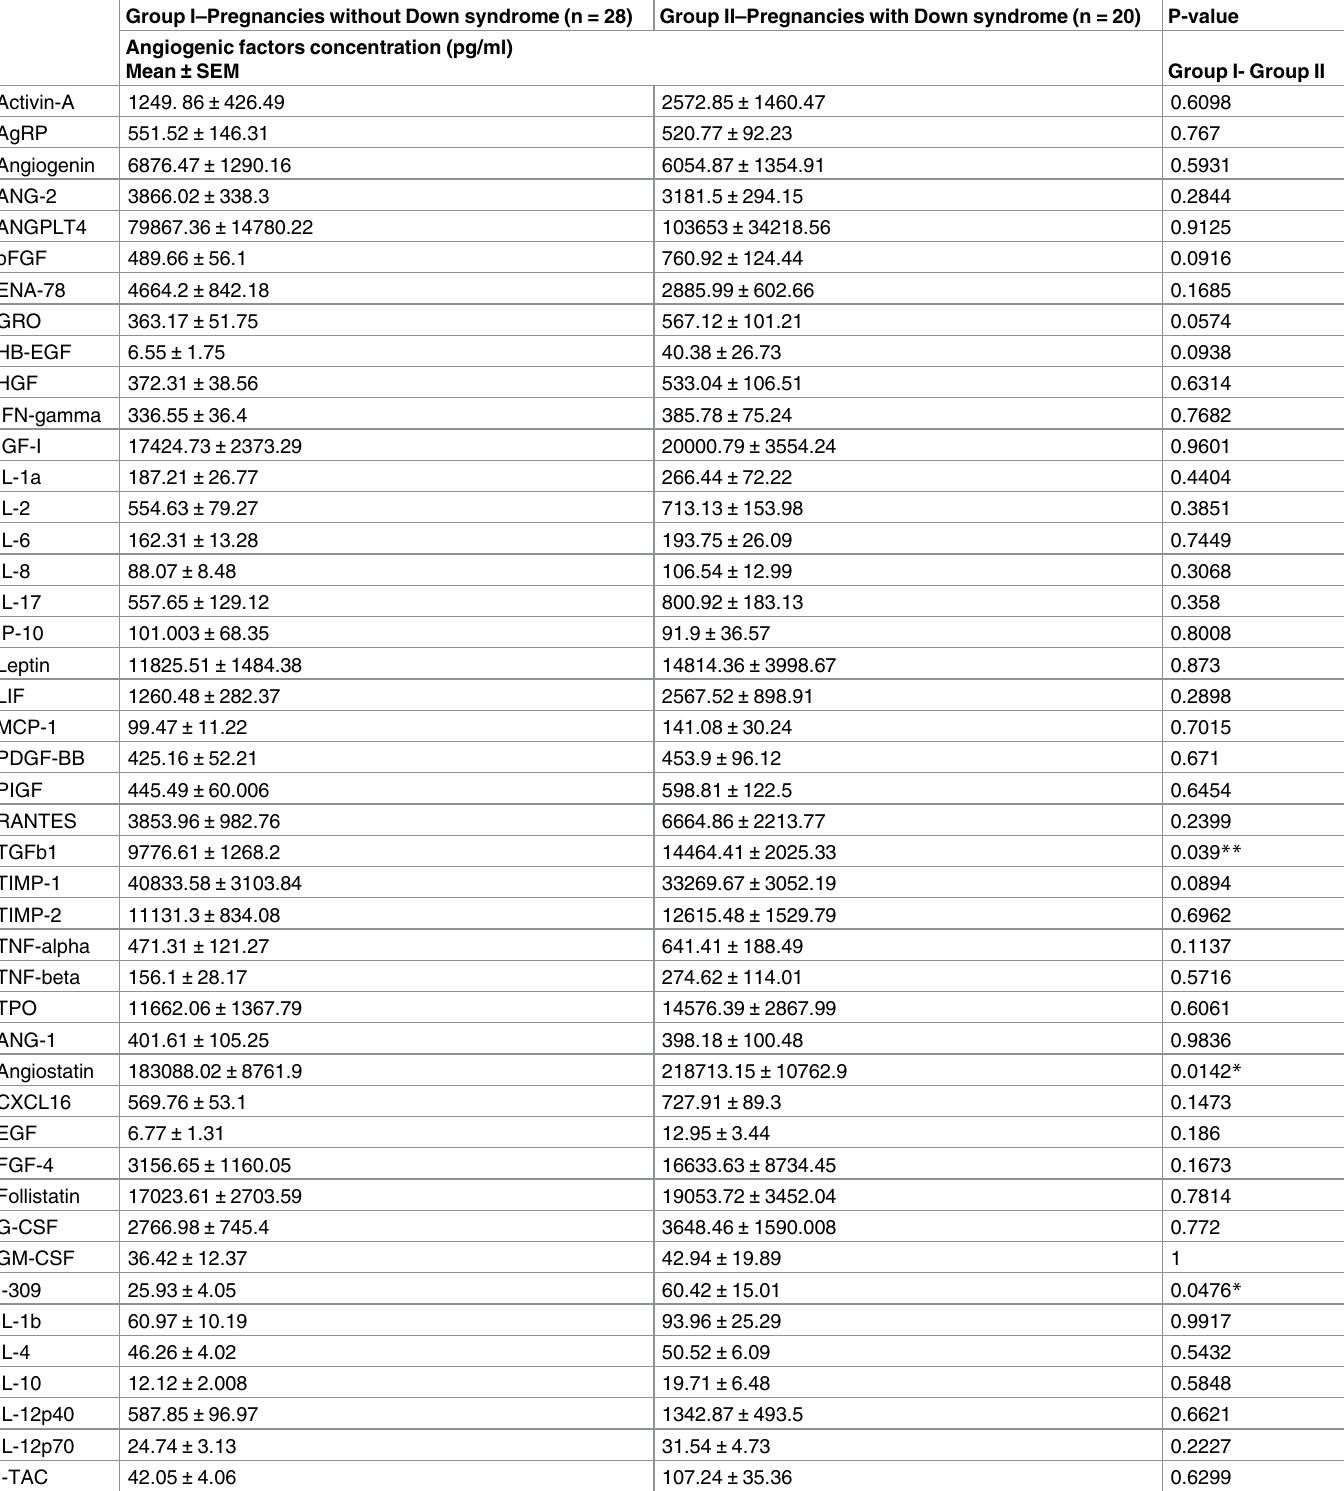
Table 2. Concentrations of angiogenic factors in maternal